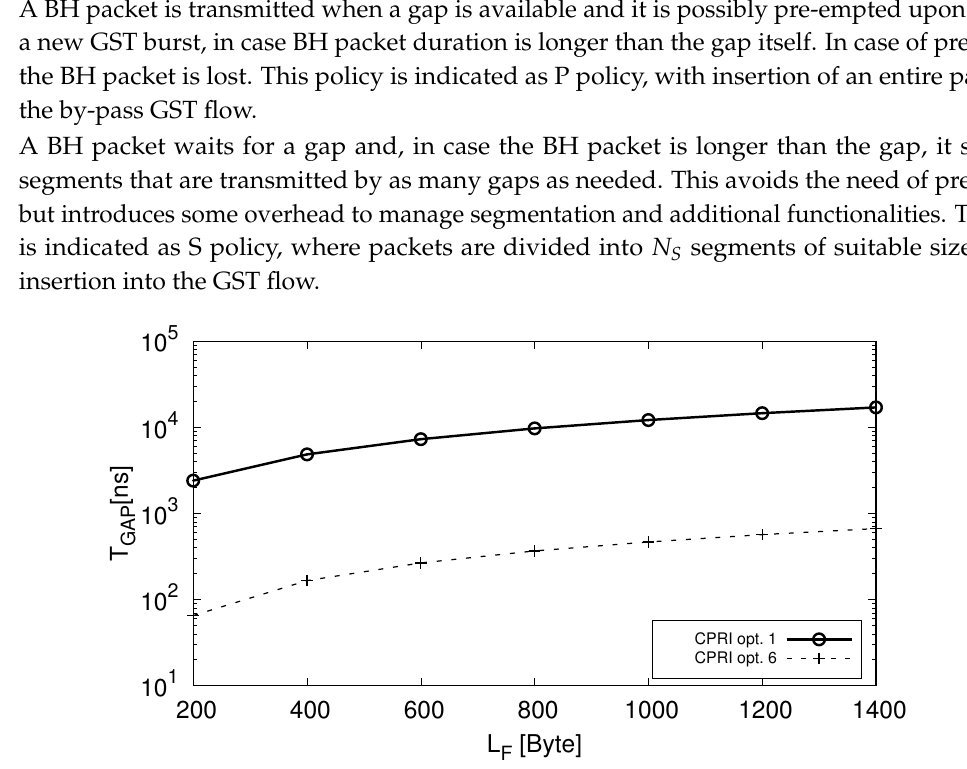
Figure 4. T GAP as a function of different values of payload length L F for CPRI opt. 1 and 6 on a 10 Gbps